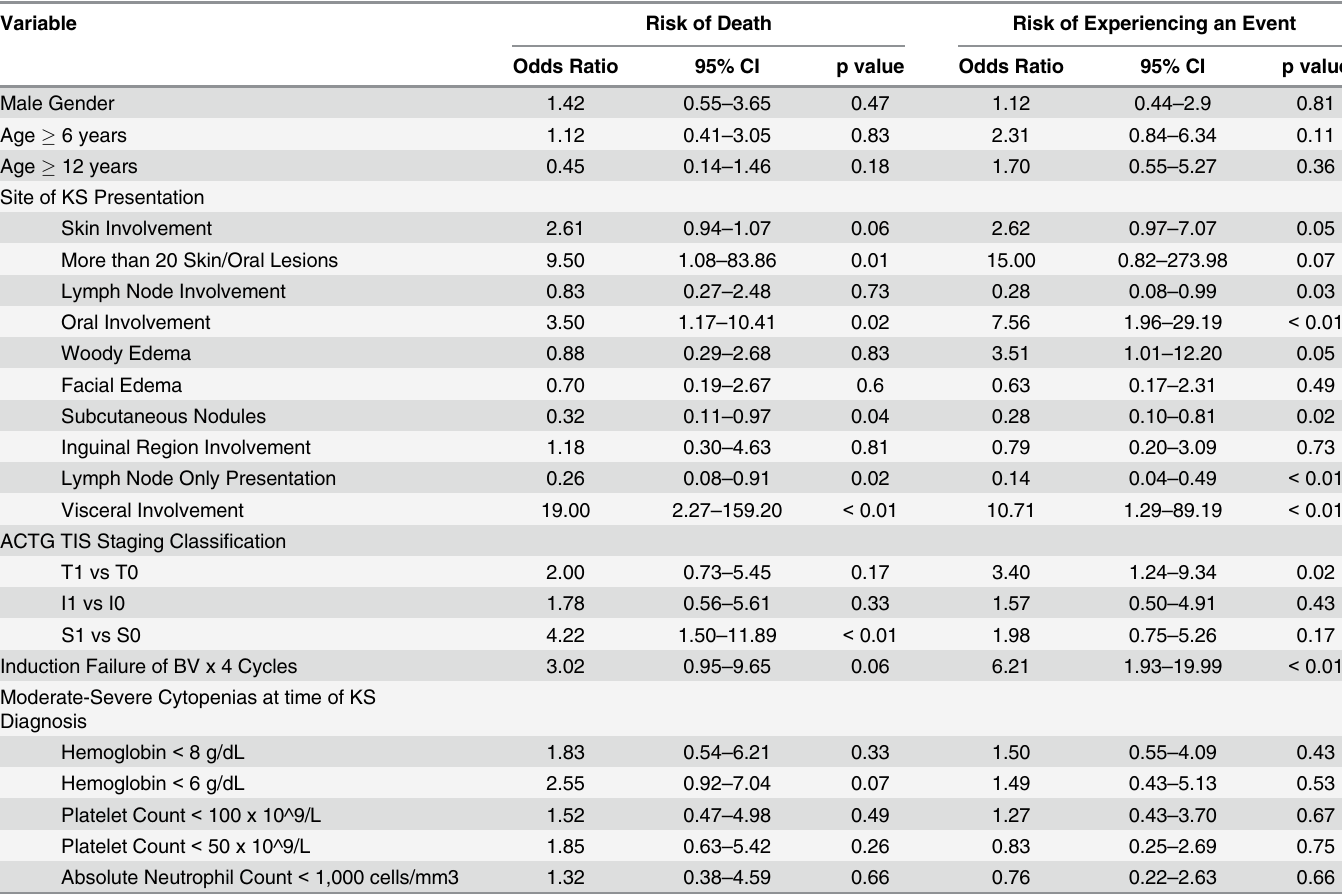
Table 2. Univariate Analysis of Variables Associated with Risk of Death and of Experiencing an